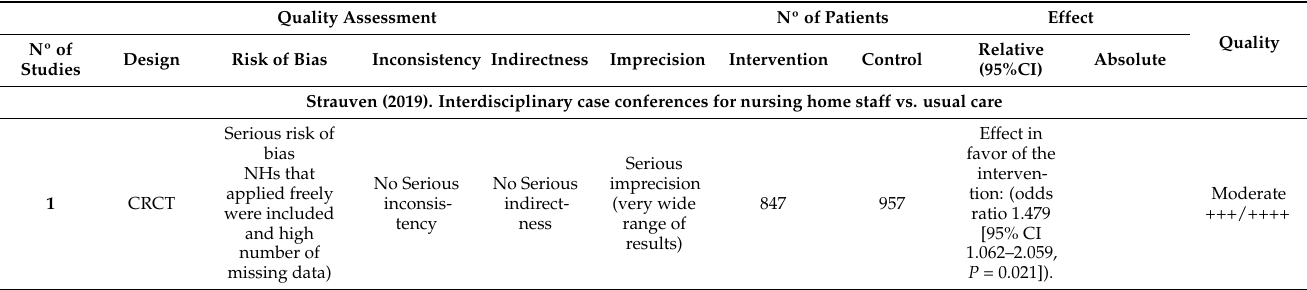
Table A4. GRADE analysis for clinical